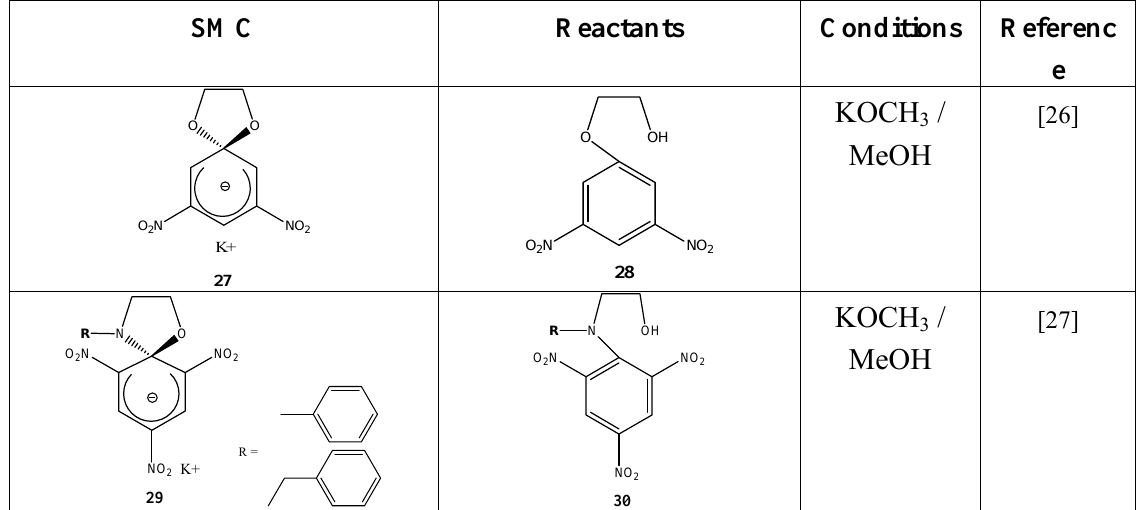
Table 1. List of stable SMCs and reaction